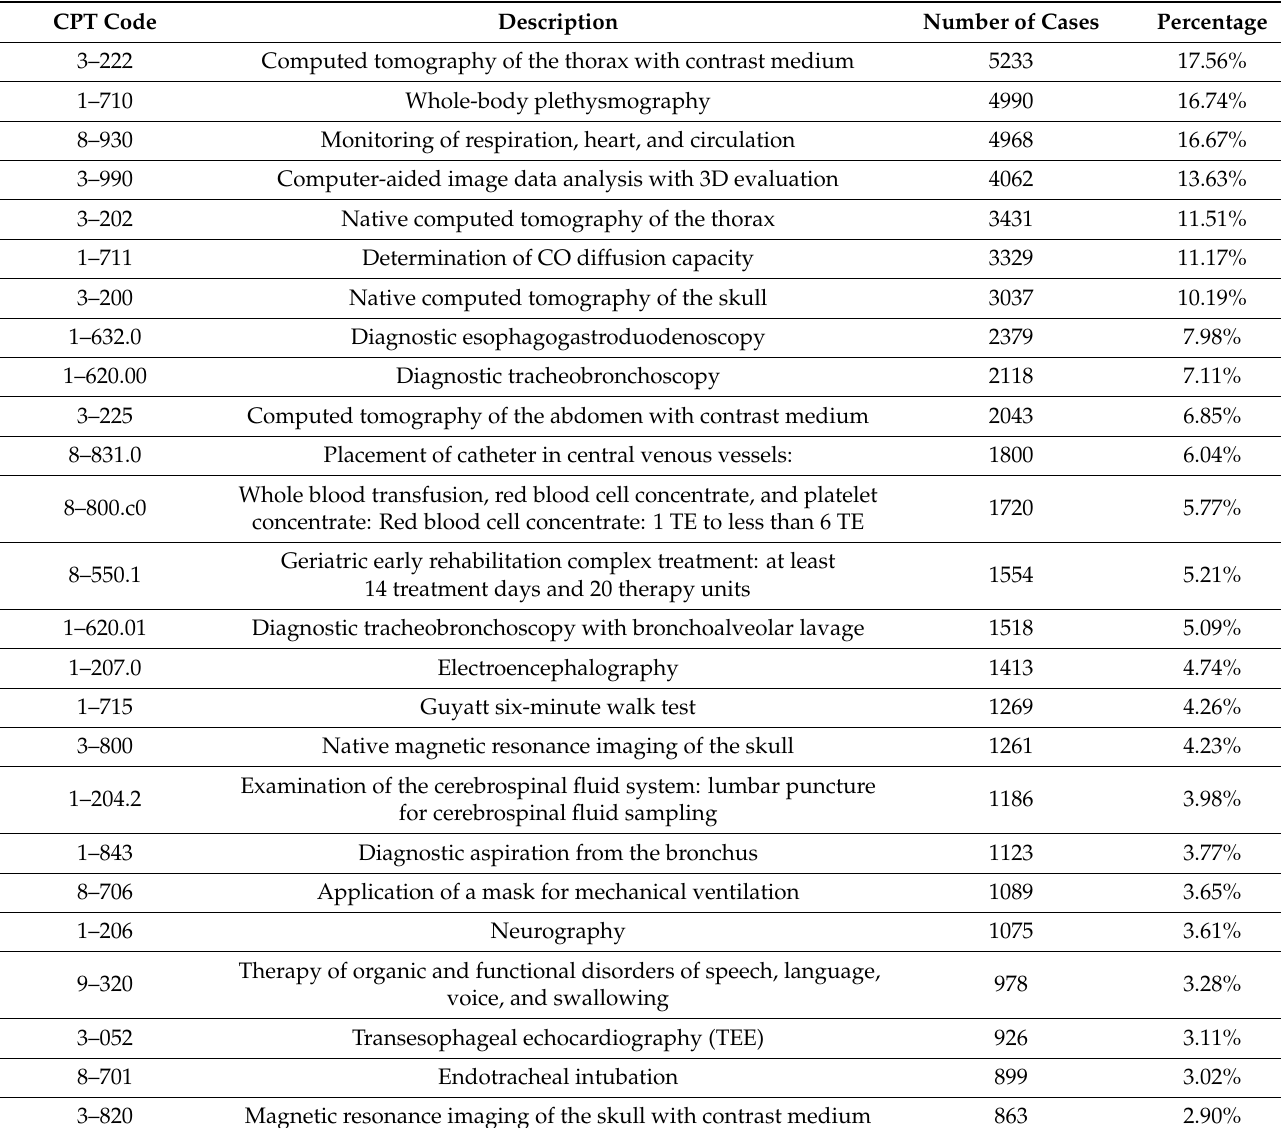
Table 3. Thirty main common procedures performed for Post-COVID syndrome